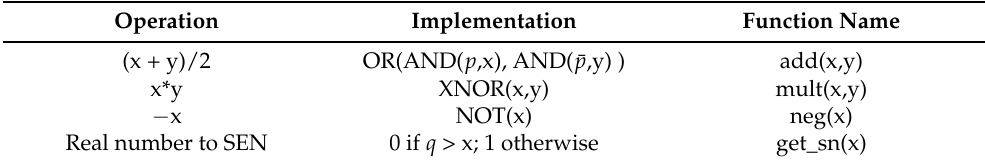
Table 1. Implementation of basic operations in Stochastic Computing in the [ − 1, 1] range. The value of p is such that it is 0 or 1 with a 0.5 probability, ¯ p = 1 − p , and q is a random variable with a normal distribution between − 1 and 1. Notice that these functions can be trivially expanded to work for arbitrary vector length. Operation Implementation Function Name (x + y)/2 OR(AND( p ,x), AND( ¯ p ,y) ) add(x,y) x*y